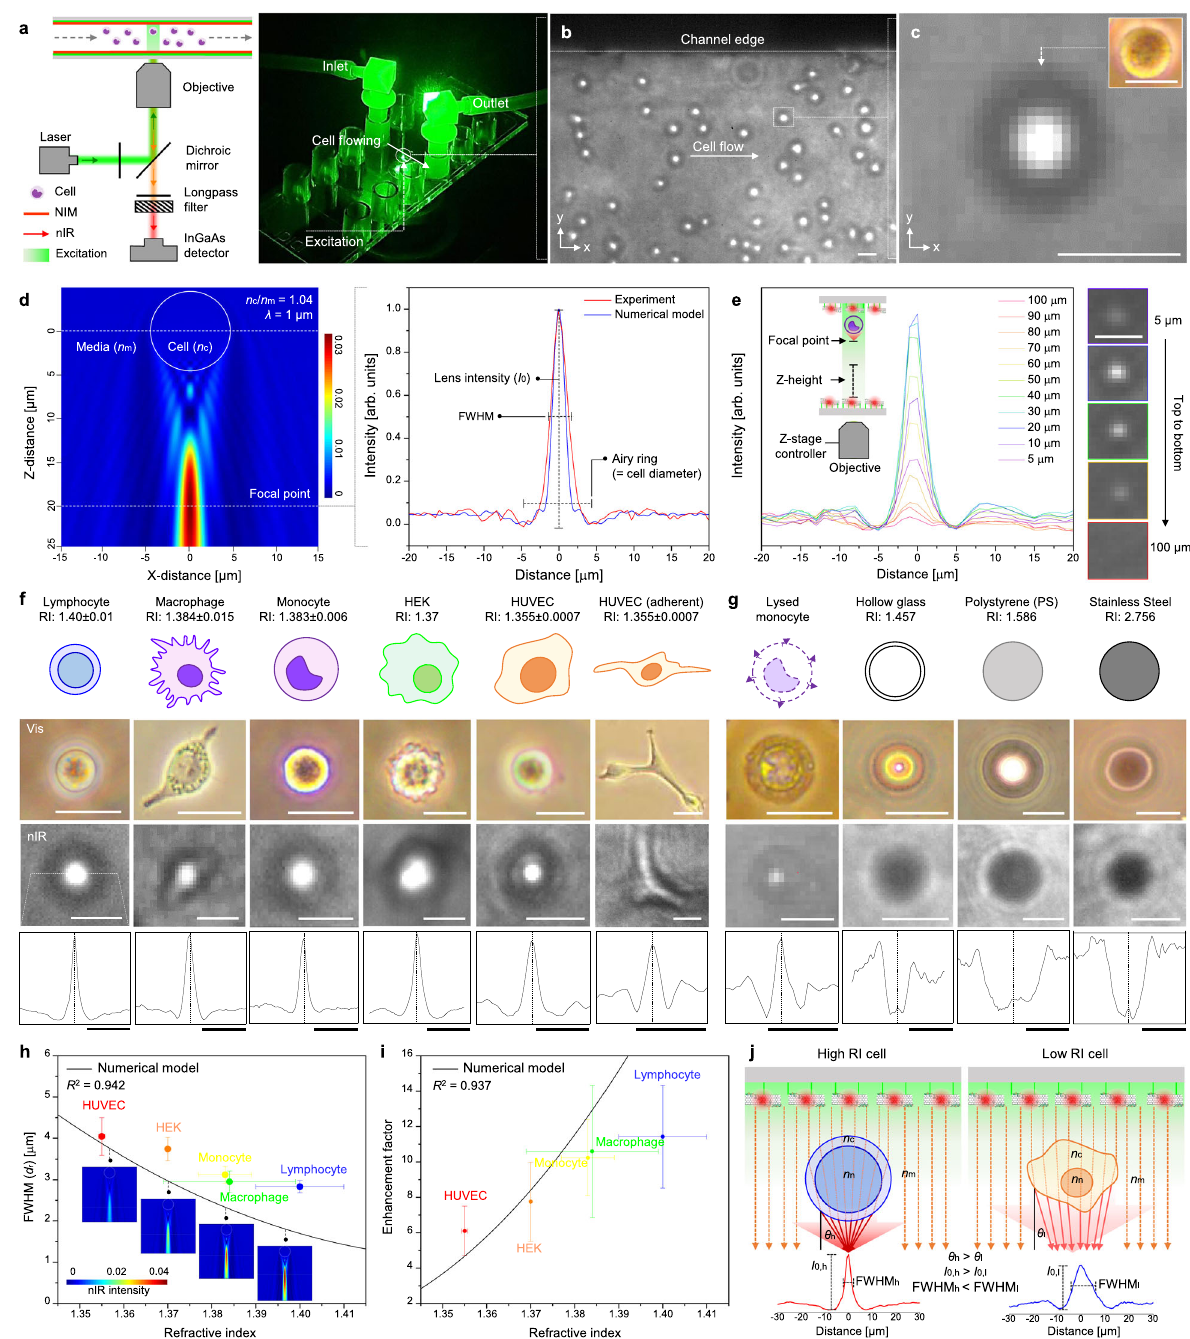
Fig. 3 Cellular lensing effect. a Instrumental setup for NCC implementation: schematic illustration (left) and a photograph (right). b nIR images of human monocytes fl owing (0.5 µ L/min) NIM. c Magni fi ed nIR image of single monocyte in NIM (inset: OM image of single monocyte). d FDTD numerical modeling for photonic nanojet and fi tting with experimental cellular lensing pro fi le ( n c / n m = 1.04, λ = 1 µ m). e nIR lensing pro fi les of a single cell with various focusing points from 5 to 100 µ m along Z-stage. nIR lensing effects of f various live cells and g reference micro-particles (top-to-bottom: schematics, OM, nIR images, lensing pro fi les). h FWHM and i enhancement factors of various cells with numerical model. Data are mean (circle) ± σ (error bar), with n cell = 10. j Schematic illustrations for different lensing behavior of a high RI cell (left) and a low RI cell (right). Scale bars: 20 µ